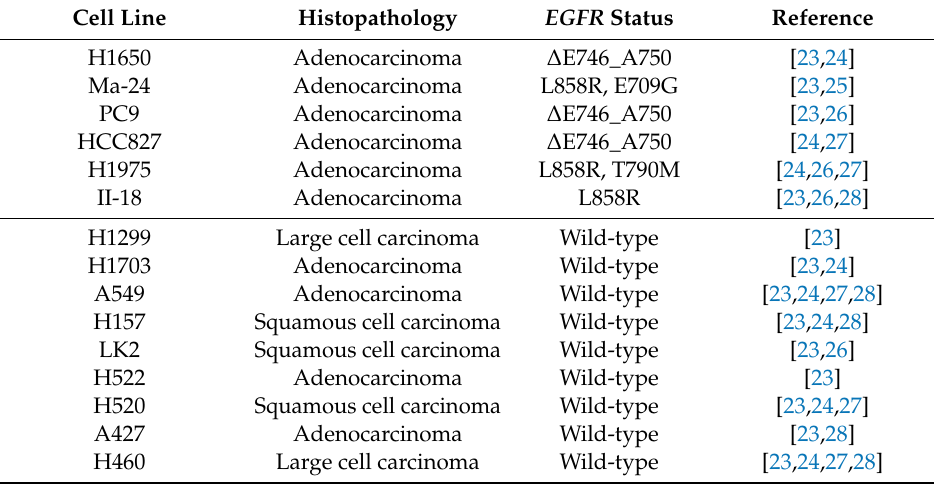
Table 3. All cell lines were cultured in RPMI-1640 (Sigma-Aldrich, St. Louis, MO, USA) supplemented with 10% fetal bovine serum (Life Technologies, Carlsbad, CA, USA). Table 3. EGFR mutation status in non-small cell lung carcinoma cell